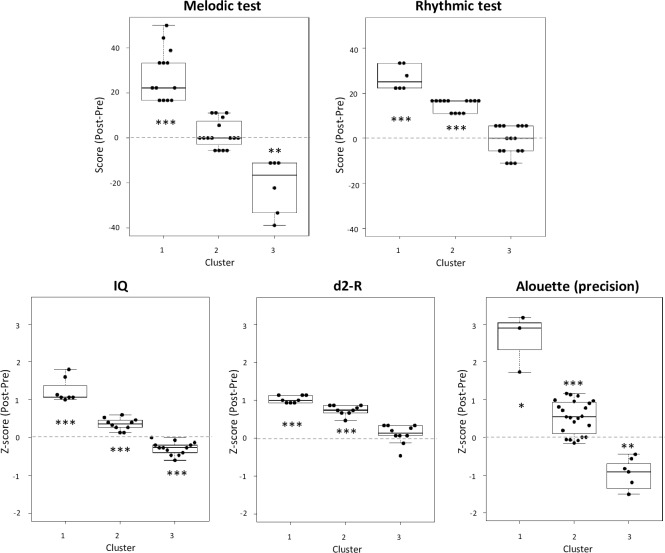
Results of cluster analyses for the five tests showing significant post minus pre- music training differences.For each test, each box plot corresponds to one cluster and the dots represent the children within each cluster. For each box plot, the upper quartile, the median and the lower quartile are represented together with the upper and lower whiskers. Significant increases or decreases in post minus pre-differences compared to 0 (no change) are indicated with *: p < .05; **: p < .01 and ***: p < .001.